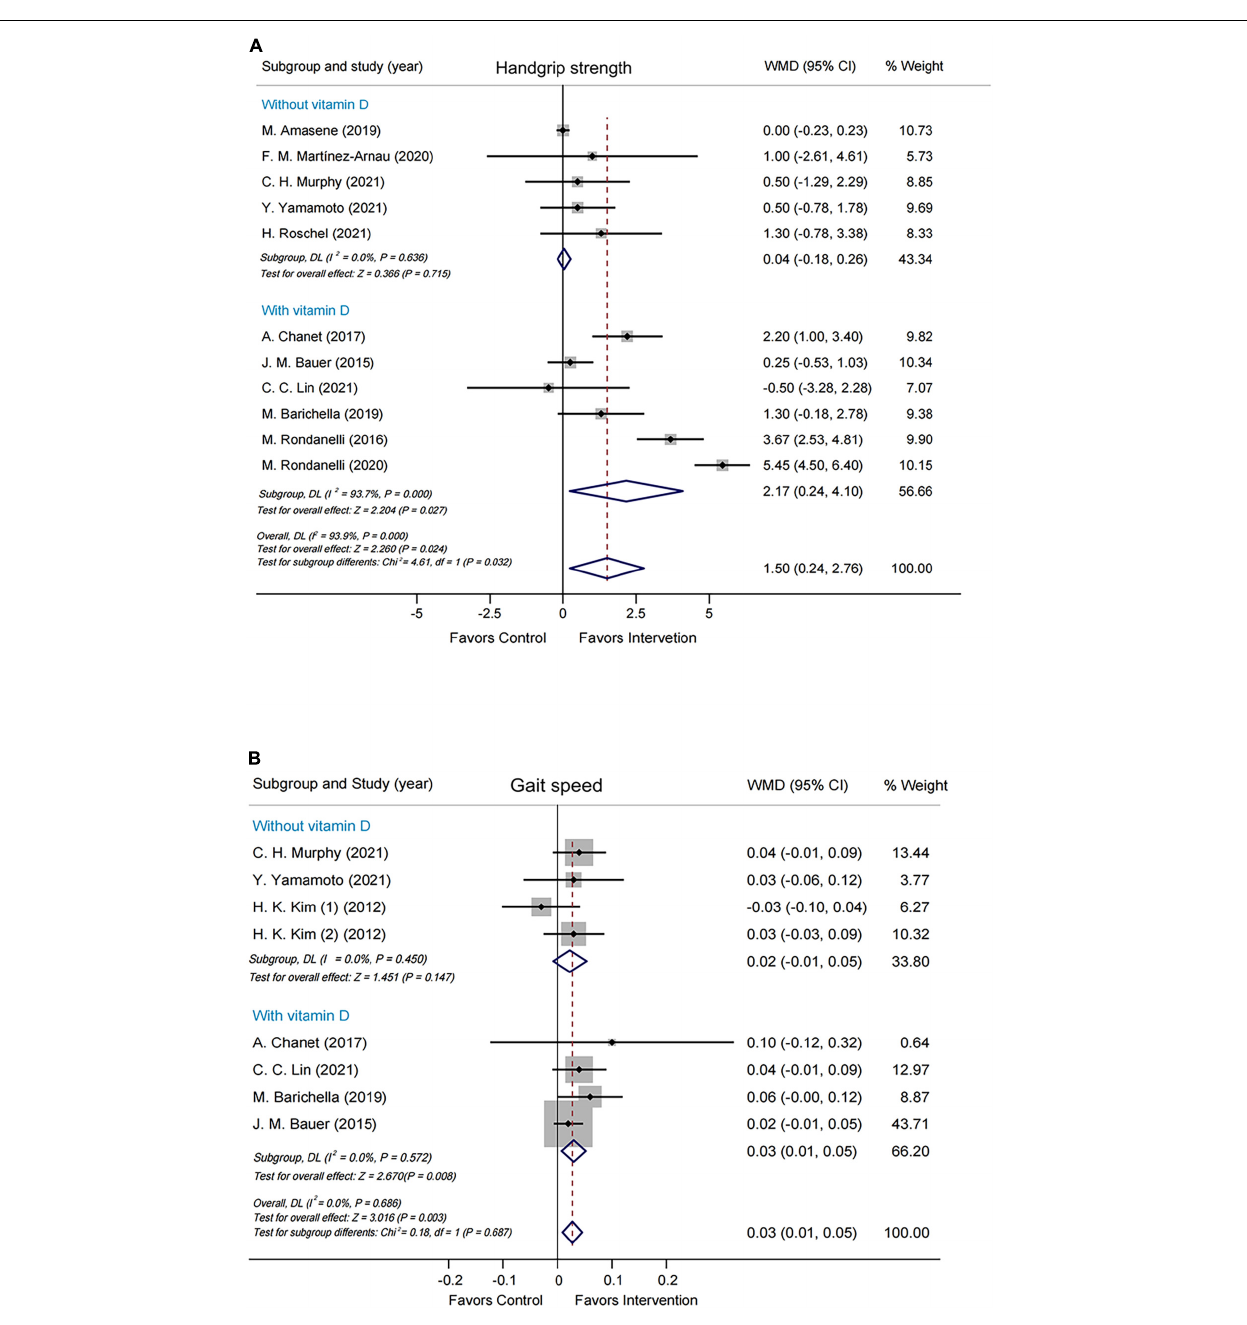
FIGURE 3 | Forest plots assessing the effect of leucine supplementation on handgrip strength (A) and gait speed (B) by groups with or without vitamin